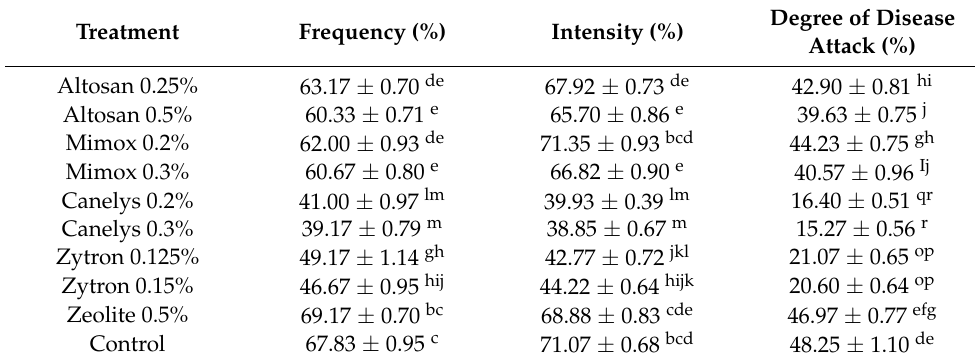
Table 4. ‘Chester’ blackberry variety response to rust disease treatments applied during 2018–2019.